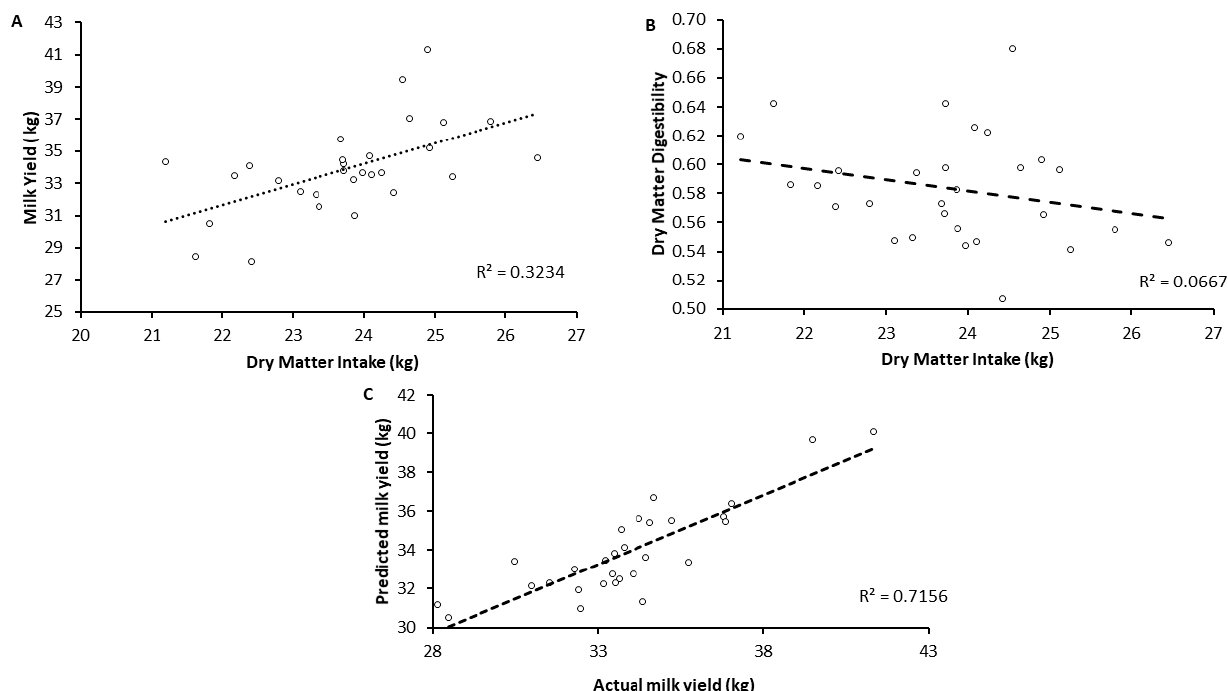
Figure 1. ( A ) Simple regression between dry matter intake and milk yield, (Mean SE = 5.45; R 2 = 0.323; Adjusted R 2 = 0.298); ( B ) Simple regression between dry matter intake and dry matter digestibility, (Mean SE = 13.48.45; R 2 = 0.067 Adjusted R 2 = 0.032); ( C ) Multiple linear regression to estimate milk yield through digested dry matter (DDM) and crude protein content, (Mean SE = 2.38; R 2 = 0.716; Adjusted R 2 = 0.694).